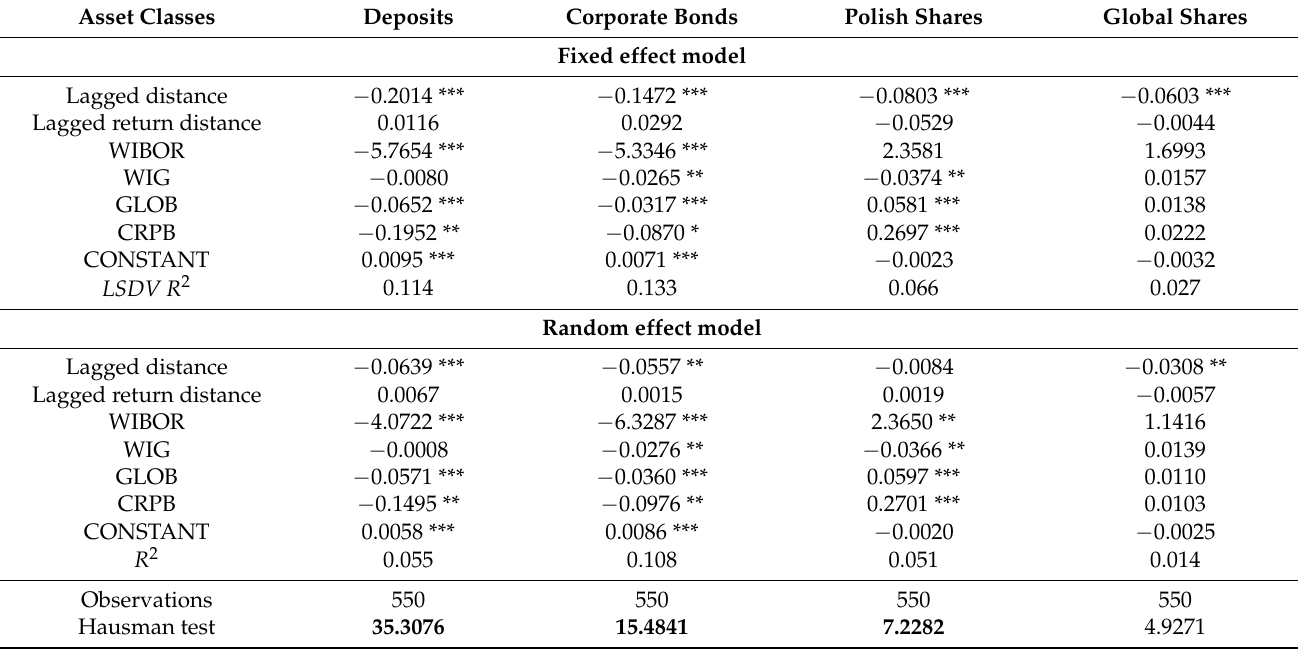
Table 4. Determinants of change in OPF asset allocations,